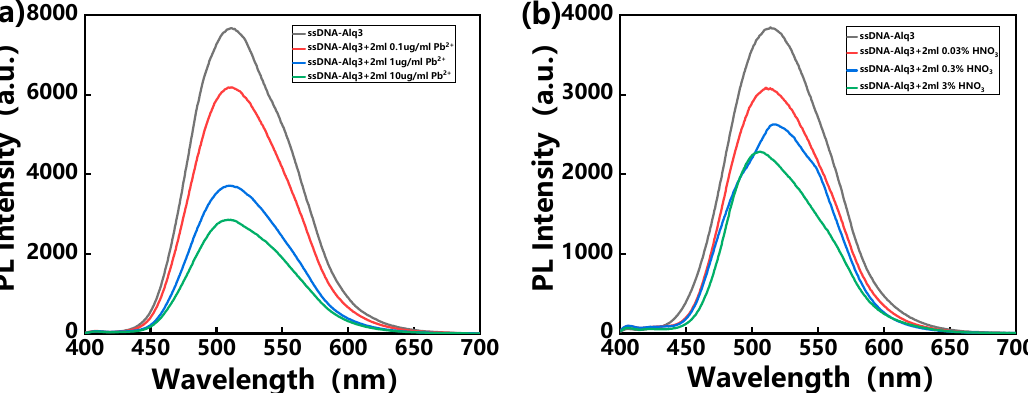
Figure 2. PL spectra of hybrid assemblies exposed to various concentrations of ( a ) Pb 2+ solution and ( b ) HNO 3 solution, with excitation at 370 nm.